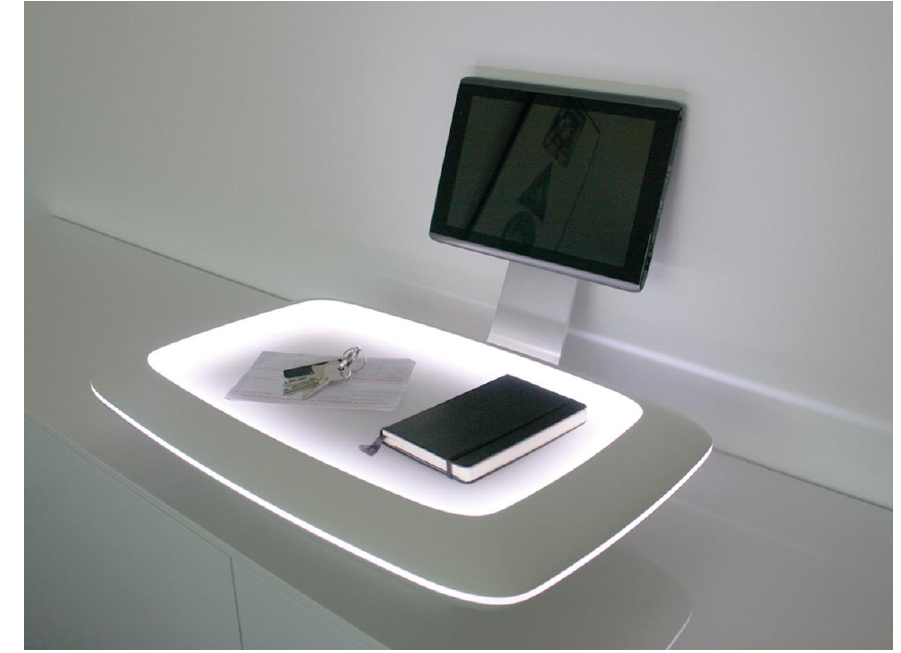
Figure 1. MeMoTray with everyday objects.